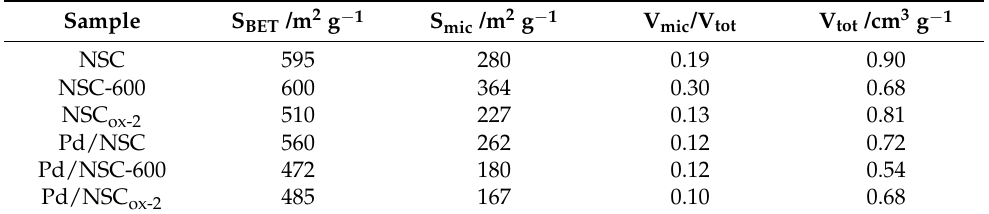
Table 1. Textural and structural properties of the carbon samples and the corresponding